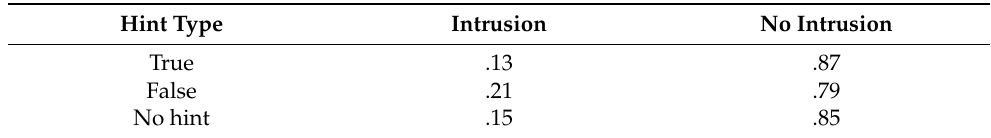
Table 2. Share of trials in which intrusions (either incorrect solutions or dropped ideas) were registered across different hint types.